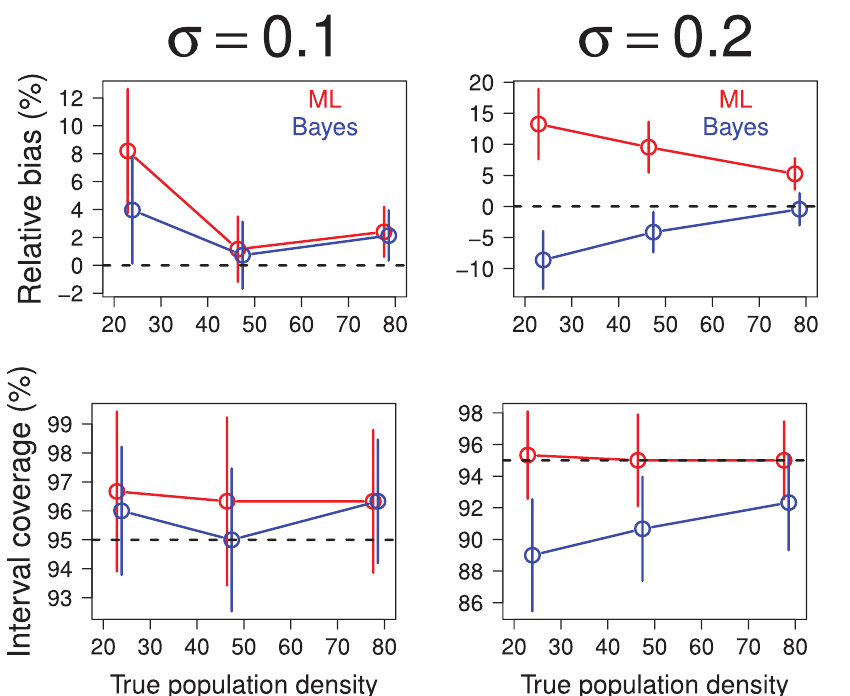
Figure 8. Comparison of maximum-likelihood and Bayes estimates of expected population density computed from analyses of simulated recaptures in area-search surveys. Estimates of relative bias are plotted in upper row. Estimates of frequentist coverage of 95% credible or confidence intervals are plotted in lower row. Error bars indicate 95% confidence intervals.